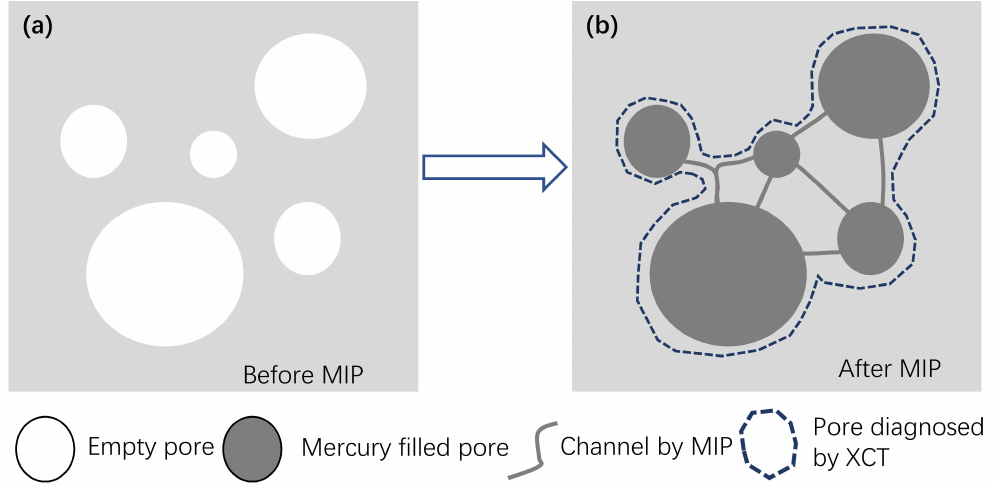
Figure 13. Mechanisms of pore damages induced by mercury intrusion under high pressures with the possibility of an overestimation on the pore size of a CBM sample after MIP (right) than that before MIP (left) by